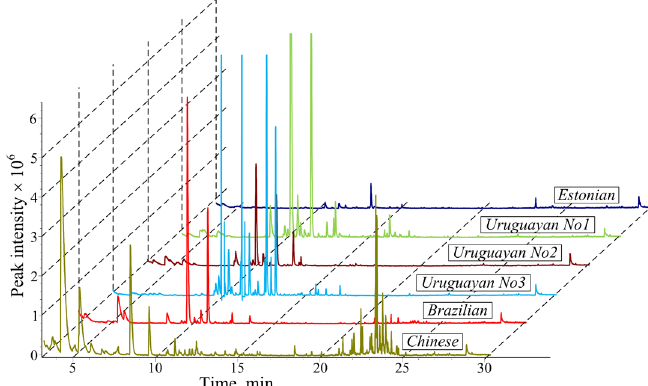
Figure 1. GC-MS chromatograms obtained from the headspace of tested propolis